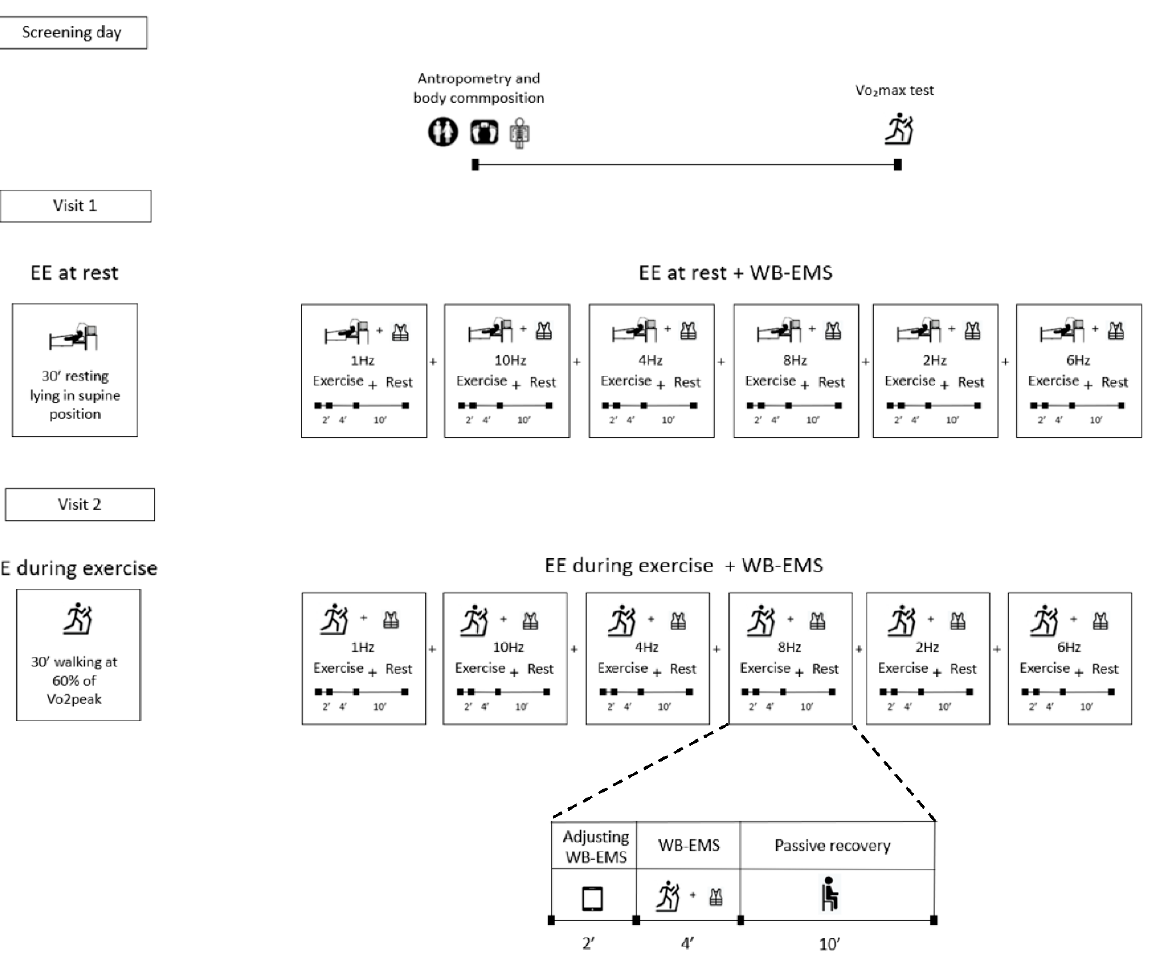
Figure 1. Study design. The different impulse frequencies were applied in a random order. Ab- breviations: VO 2 max, maximal oxygen uptake, EE, energy expenditure, WB-EMS, whole-body